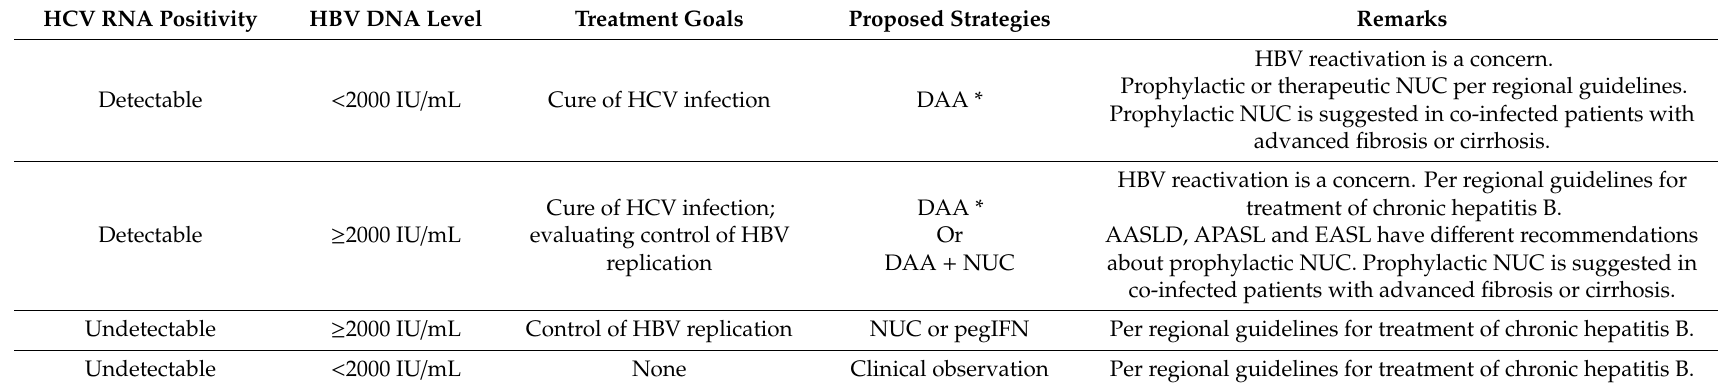
Table 3. Proposed strategies for the treatment of patients with HCV / HBV